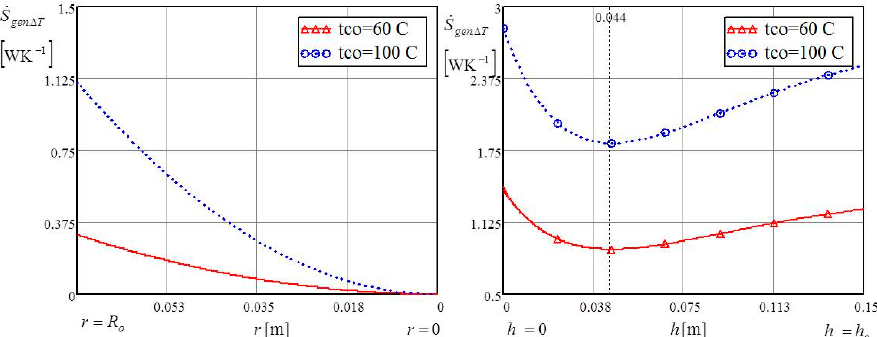
Figure 9. The thermal entropy of the individual influence of the bottom and the vertical annular channel. The minimum of the thermal entropy 0.044 m from the bottom. This was the same position for both test temperatures of 60 °C and 100 °C. The reason for the existence of the minimum thermal entropy in the annular channel was that the liquid temperature and the wall temperature of the annular channel rose in the same direction. Thus, closer to the bottom, the liquid temperature )( hT )( hT both increased towards bottom temperature 1 c additionally rose from the heat impact of the bottom at constant temperature liquid exited the cylindrical cavity with temperature